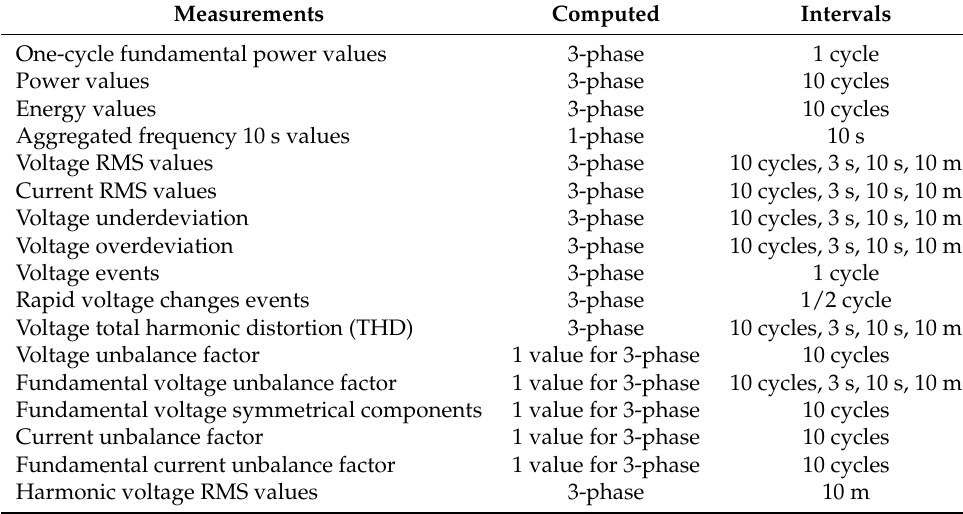
Table 1. Real-time processing of power quality measurements in programmable controller.